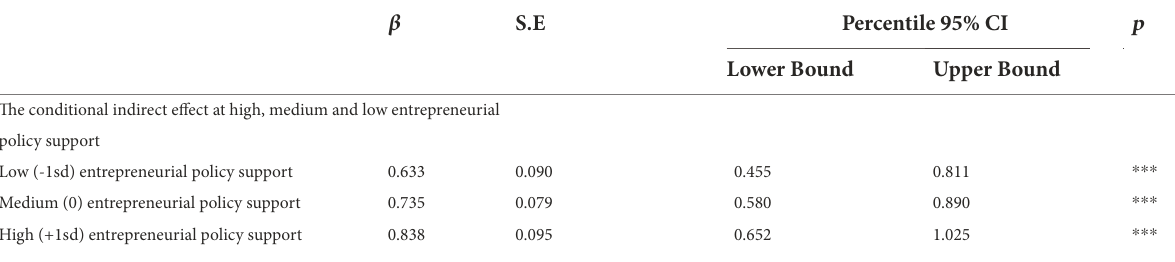
TABLE 6 | Conditional indirect effect of improvisation on entrepreneurial intention through entrepreneurial self-efficacy.